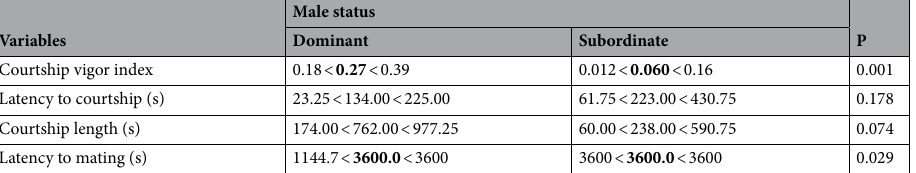
Table 7. Courtship variables of Anastrepha curvicauda dominant and subordinate (7–8 days old) males. Choice experiments. Reported values are Q1 < Median < Q3 (n = 15). Medians in bold in the same row are significantly different (Mann–Whitney test, p >